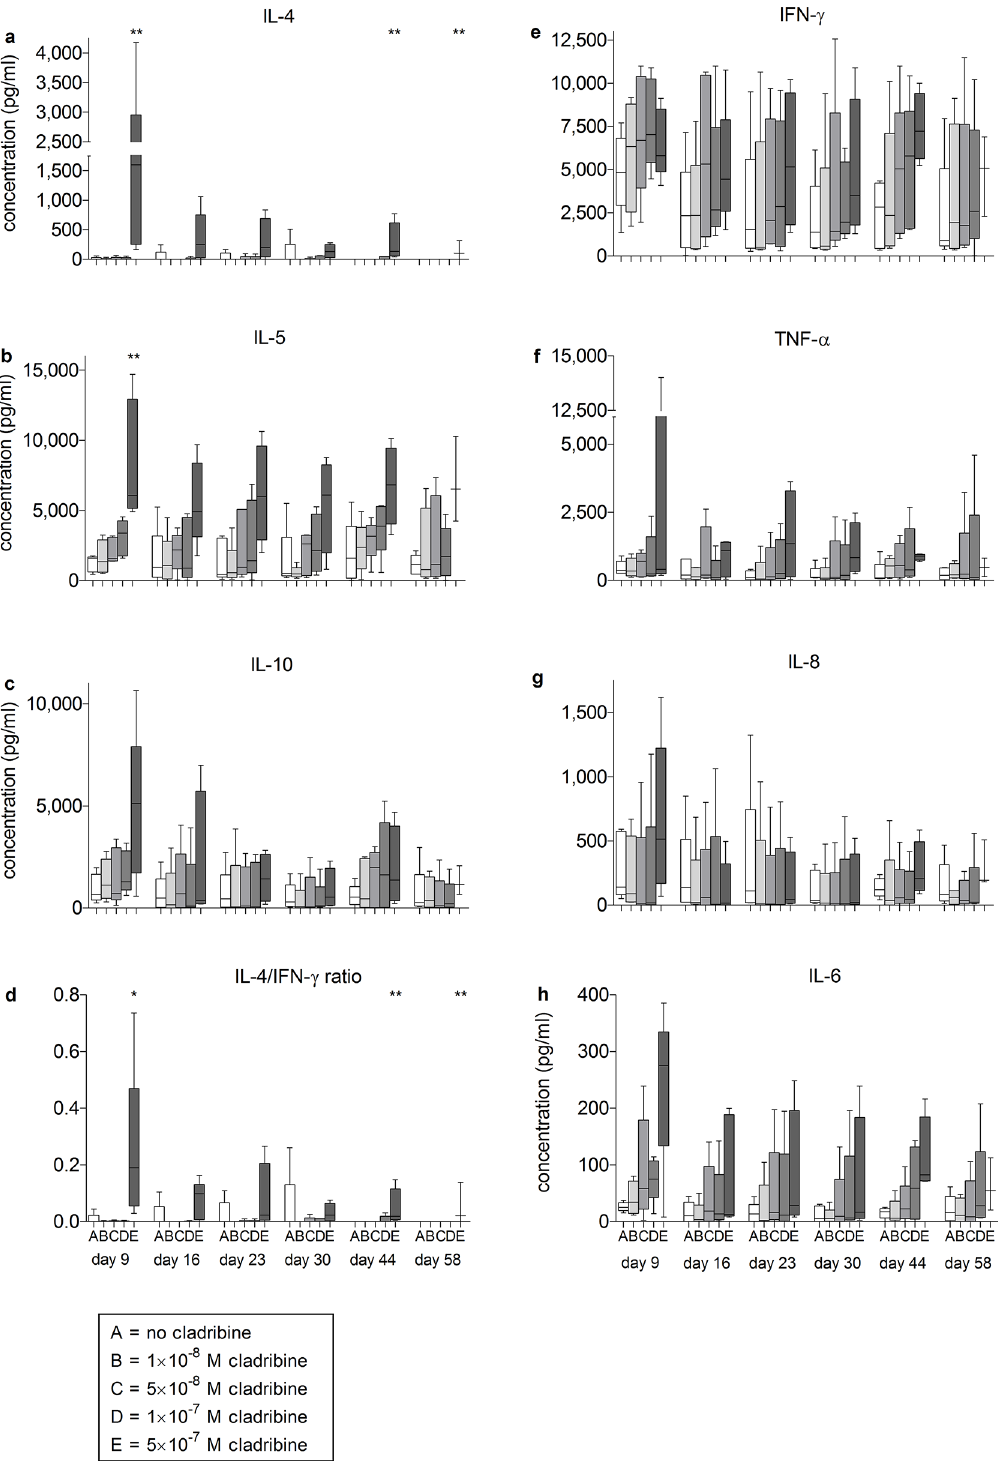
Fig 4. In vitro effects of initial cladribine treatment on cytokine secretion of PBMCs restimulated at Days 9, 16, 23, 30, 44 and 58 after transfer into cladribine-free medium. PBMCs from healthy blood donors (n = 5) were incubated in the absence or presence of cladribine. (1×10 − 8 M to 5×10 − 7 M) for 72 h. Then cells were washed three times and transferred into cladribine-free medium. Cells were restimulated with anti-CD3/anti-CD28 antibodies for 48 h at days 9, 16, 23, 30, 44 and 58; supernatants were collected and cytokine concentrations were determined. Data are depicted as box plot diagrams. Whiskers represent maximum and minimum values. The IL-4/IFN- γ ratio was defined as the ratio of IL-4 (pg/ml) to IFN- γ (pg/ml). * : p < 0.05; ** : p <